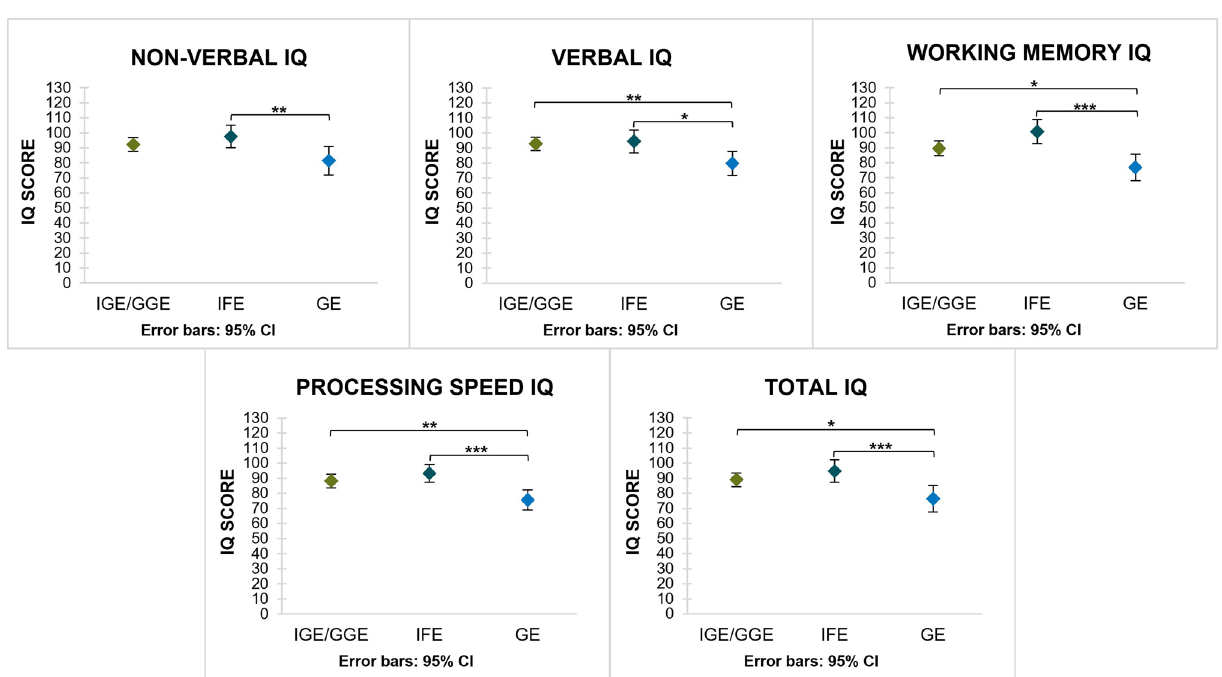
Figure 2. IQ means of epilepsy groups for all IQ categories; significant differences marked by bars and asterisks, non-significant differences are not shown. * p ≤ 0.05; ** p ≤ 0.01; *** p ≤